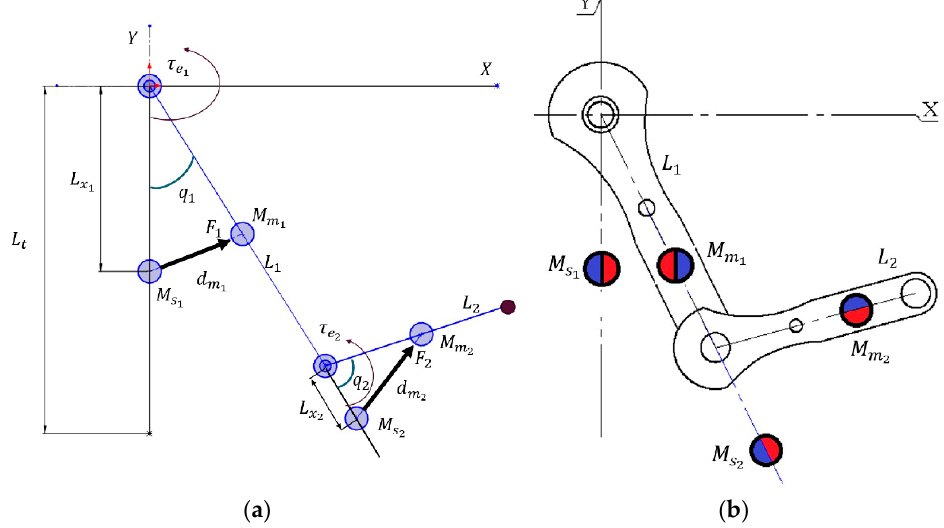
Figure 4. Displacement–force scheme between magnets in a mechanism: ( a ) diagram, ( b ) conceptual sketch.